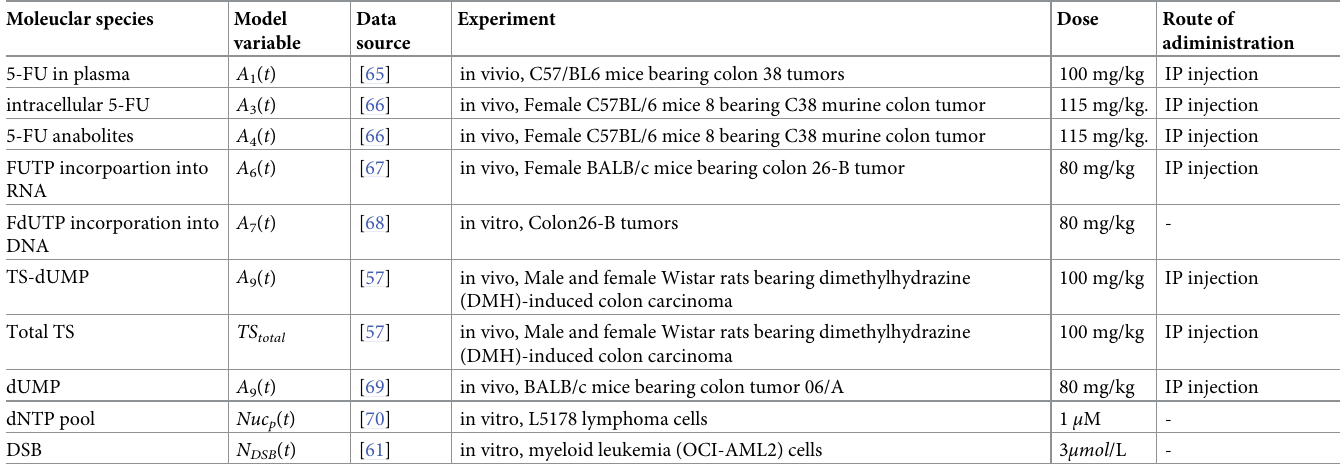
Table 2. Literature data for the model variables.